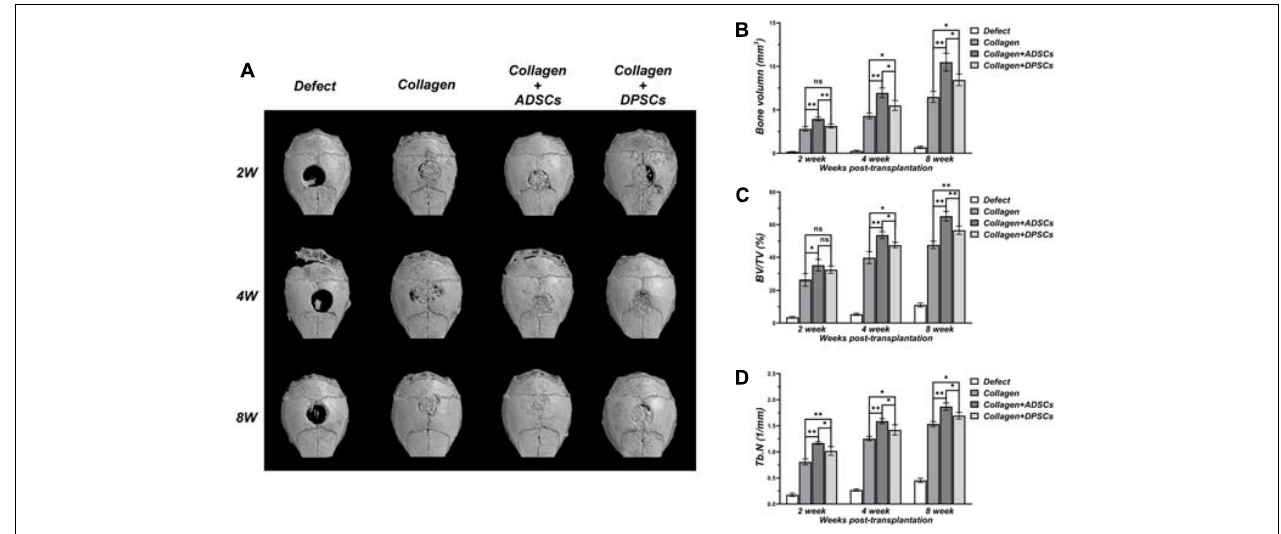
FIGURE 3 | Three dimensional µ CT analyses of bone regeneration in bone defect areas of Control, Bio-Oss Collagen, Bio-Oss Collagen + ADSCs, and Bio-Oss Collagen + DPSCs groups. (A) Representative µ CT images at 2, 4, and 8 weeks. (B) Bone volume (BV), (C) Bone volume/total volume (BV/TV), (D) Trabecular number (Tb.N) by µ CT at each time-point. Data are presented as the mean ± standard deviation, * P < 0.05, ** P <